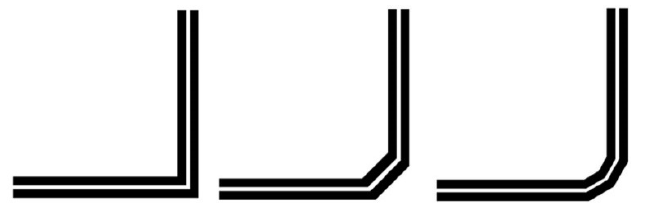
Figure 2. Top views of 90-degree bend and smooth bend structures with 135- and 150-degree bends.